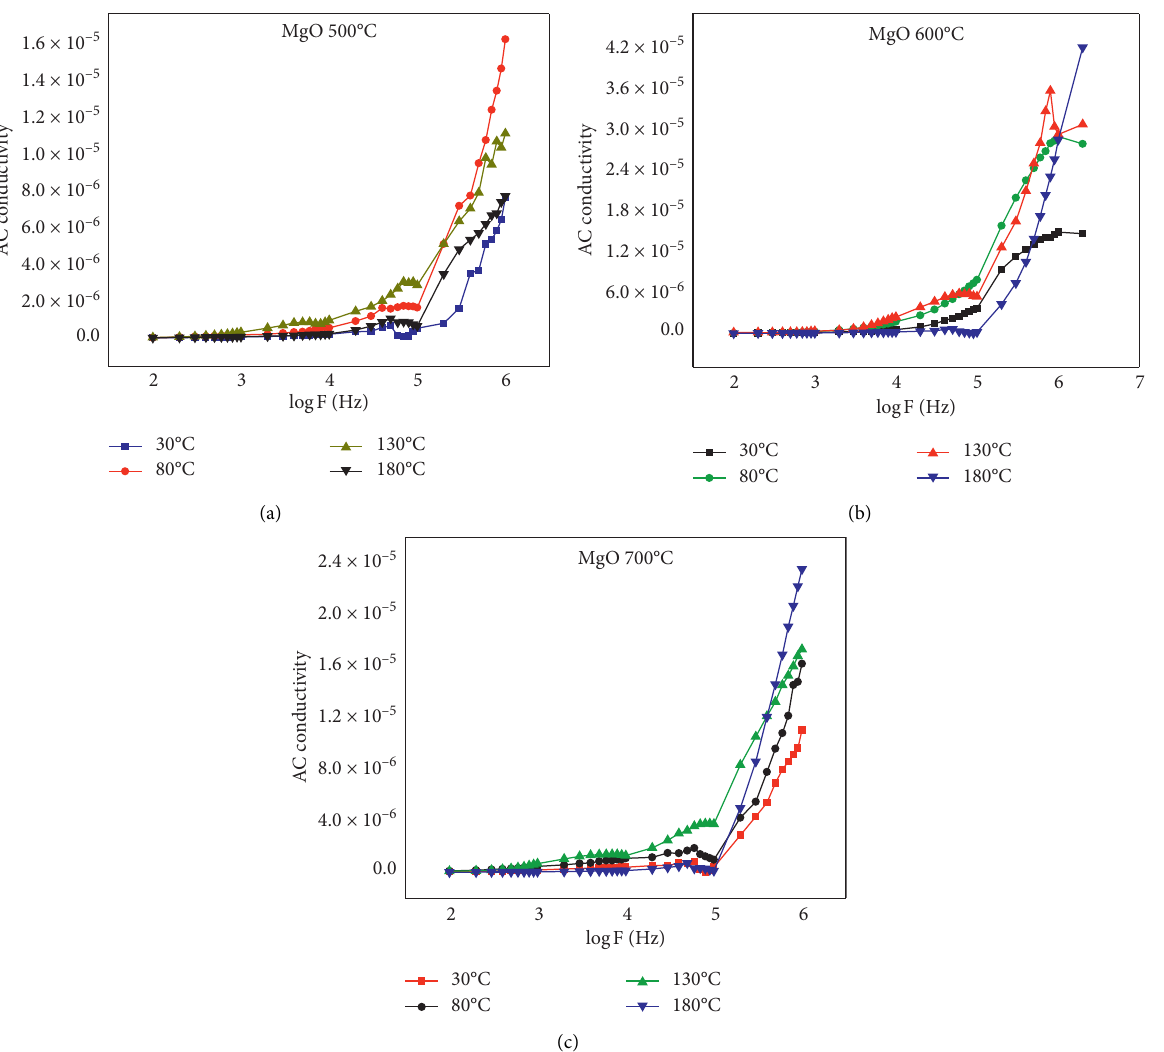
Figure 17: AC conductivity of MgO nanoparticles at 500 ° C (a), 600 ° C (b), and 700 ° C (c) with different